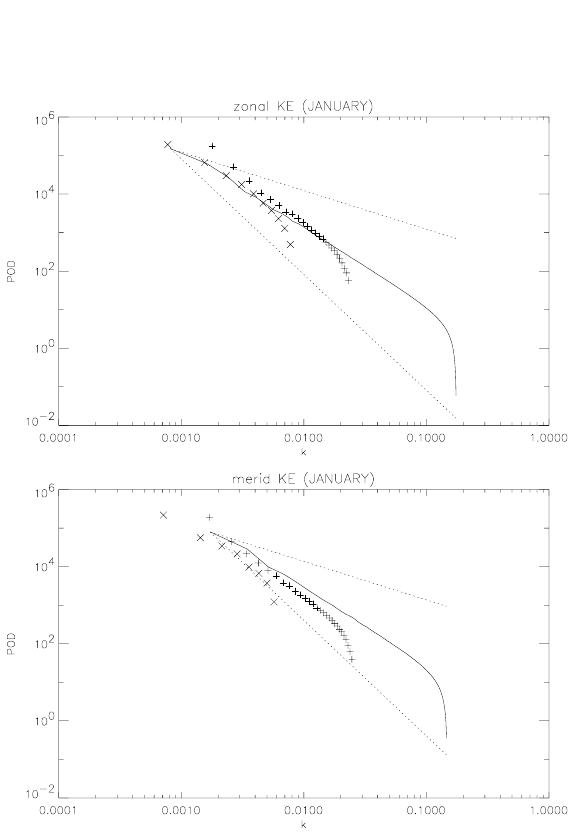
Fig. 1. Kinetic energy (KE) power spectra for winter (January). The power density (POD) is represented as a function of zonal and meridional wave number: the maximum resolved scale is about 40km (see Fig. 3). For comparison, the theoretical slopes k − 3 and 5 k − 3 are represented by dashed lines. Starting from the top left the symbols represents the values derived, respectively: from NCEP reanalysis ( × ) from LMDZ ( + ) and from BOLAM (solid line).